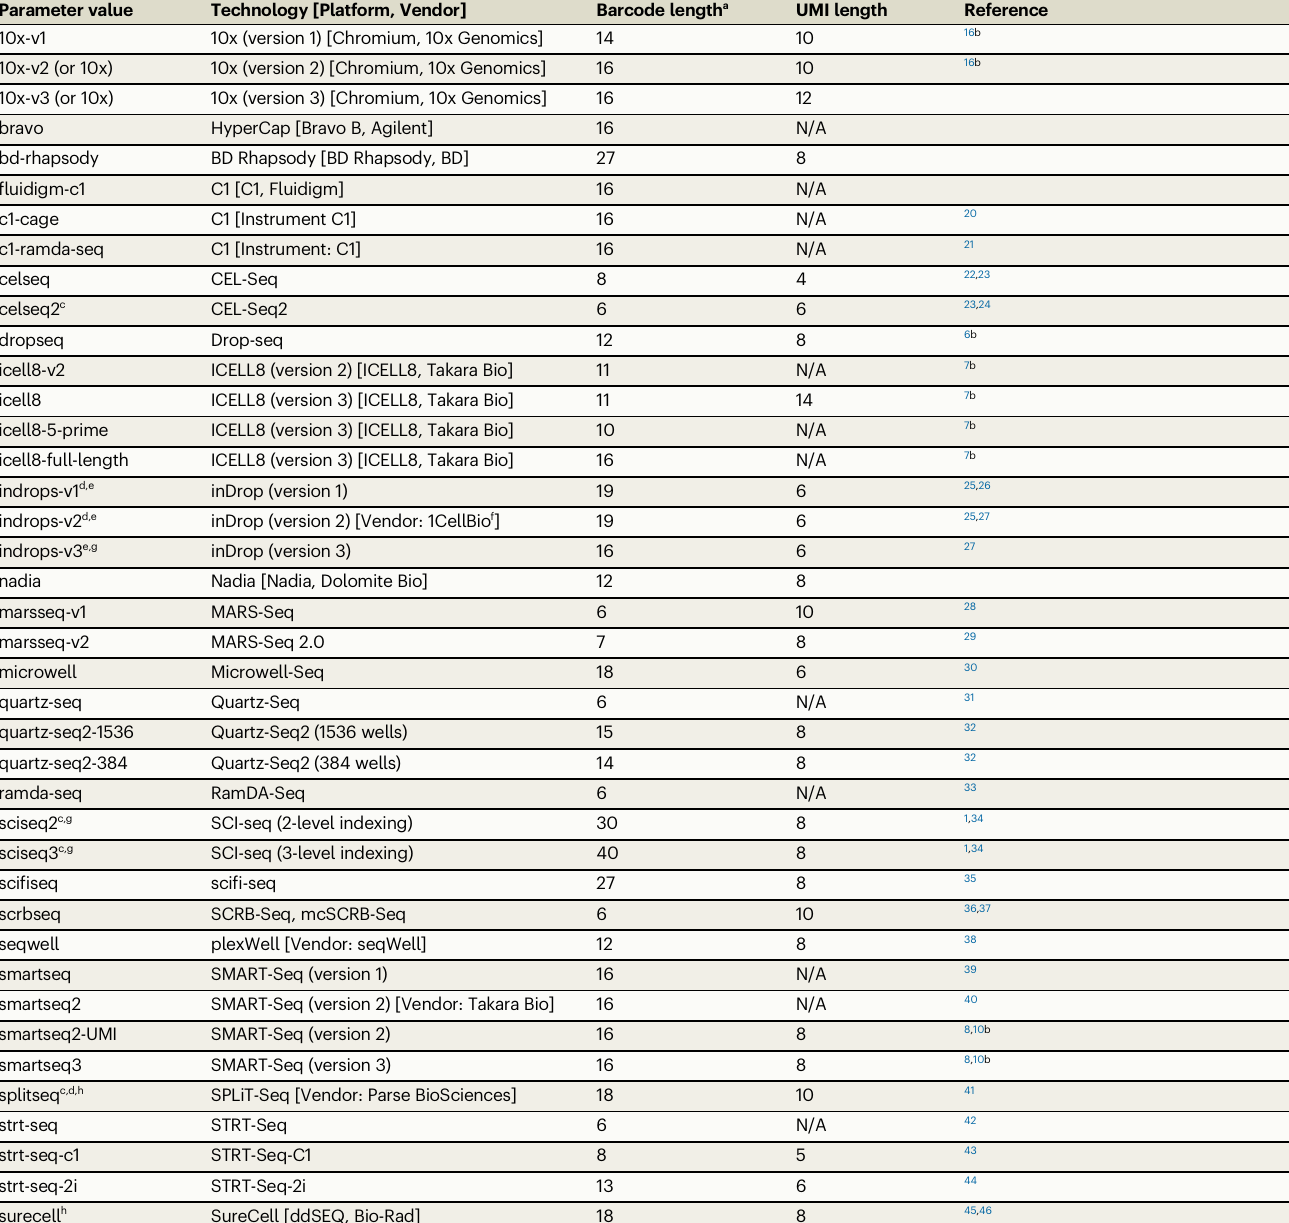
Table 1 | Technologies currently available and settings used by UniverSC Parameter